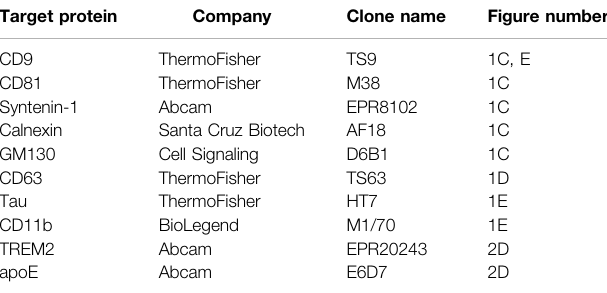
TABLE 1 | Antibodies used for immunoblot analysis of small EV (F2) fractions and microglial EVs isolated from human parietal cortex. Target